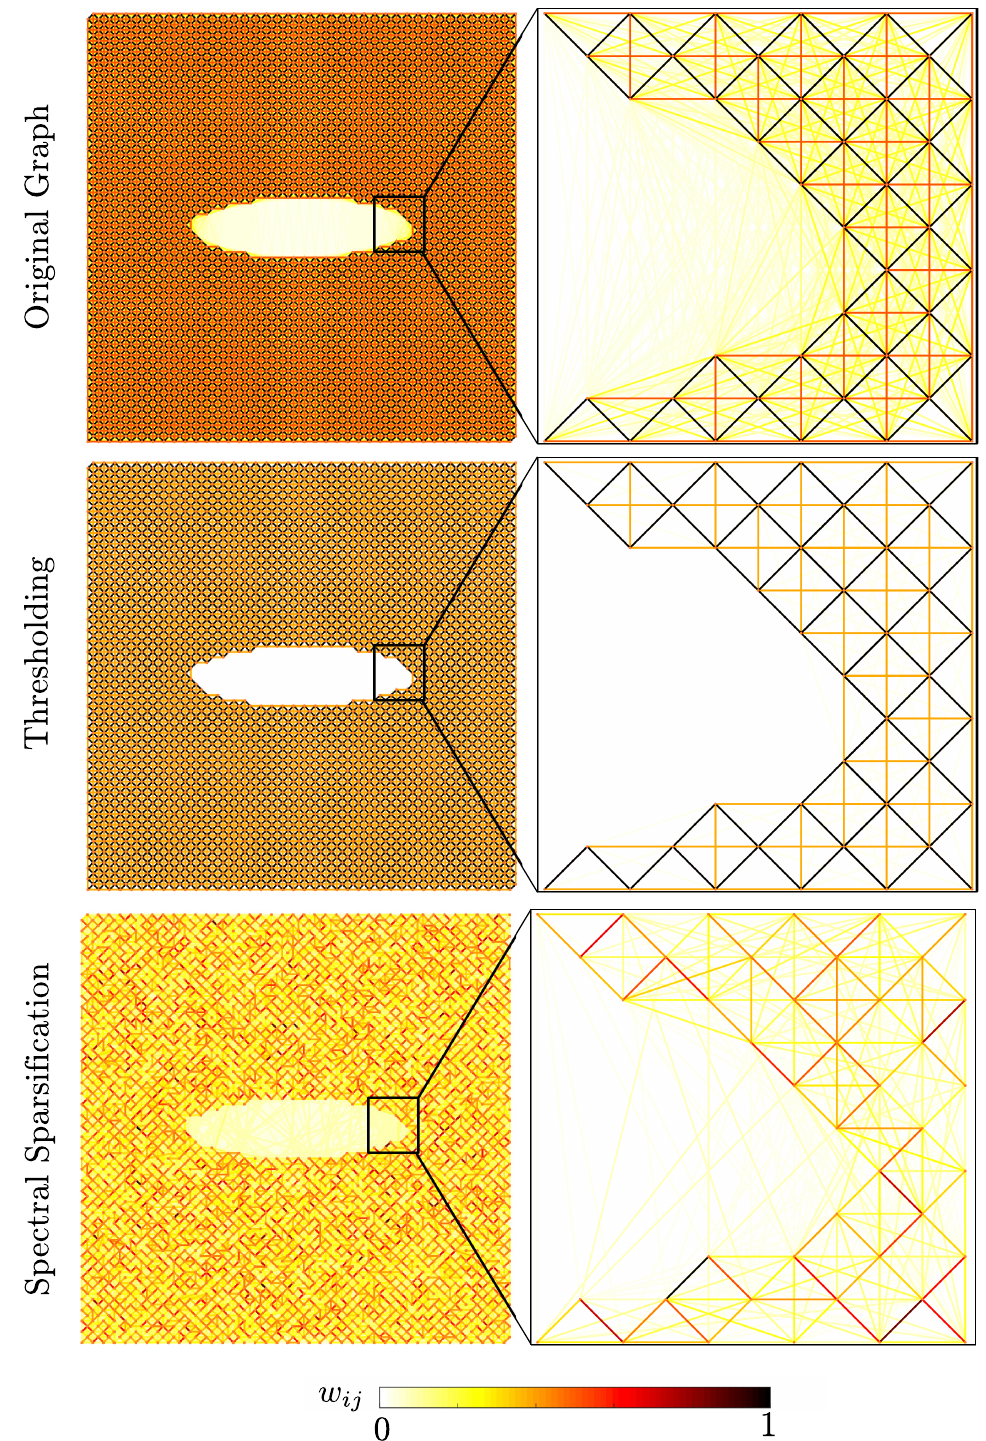
Fig 1. Coulomb force graph with thresholding and with spectral sparsification. The color represents the normalized edge weight.